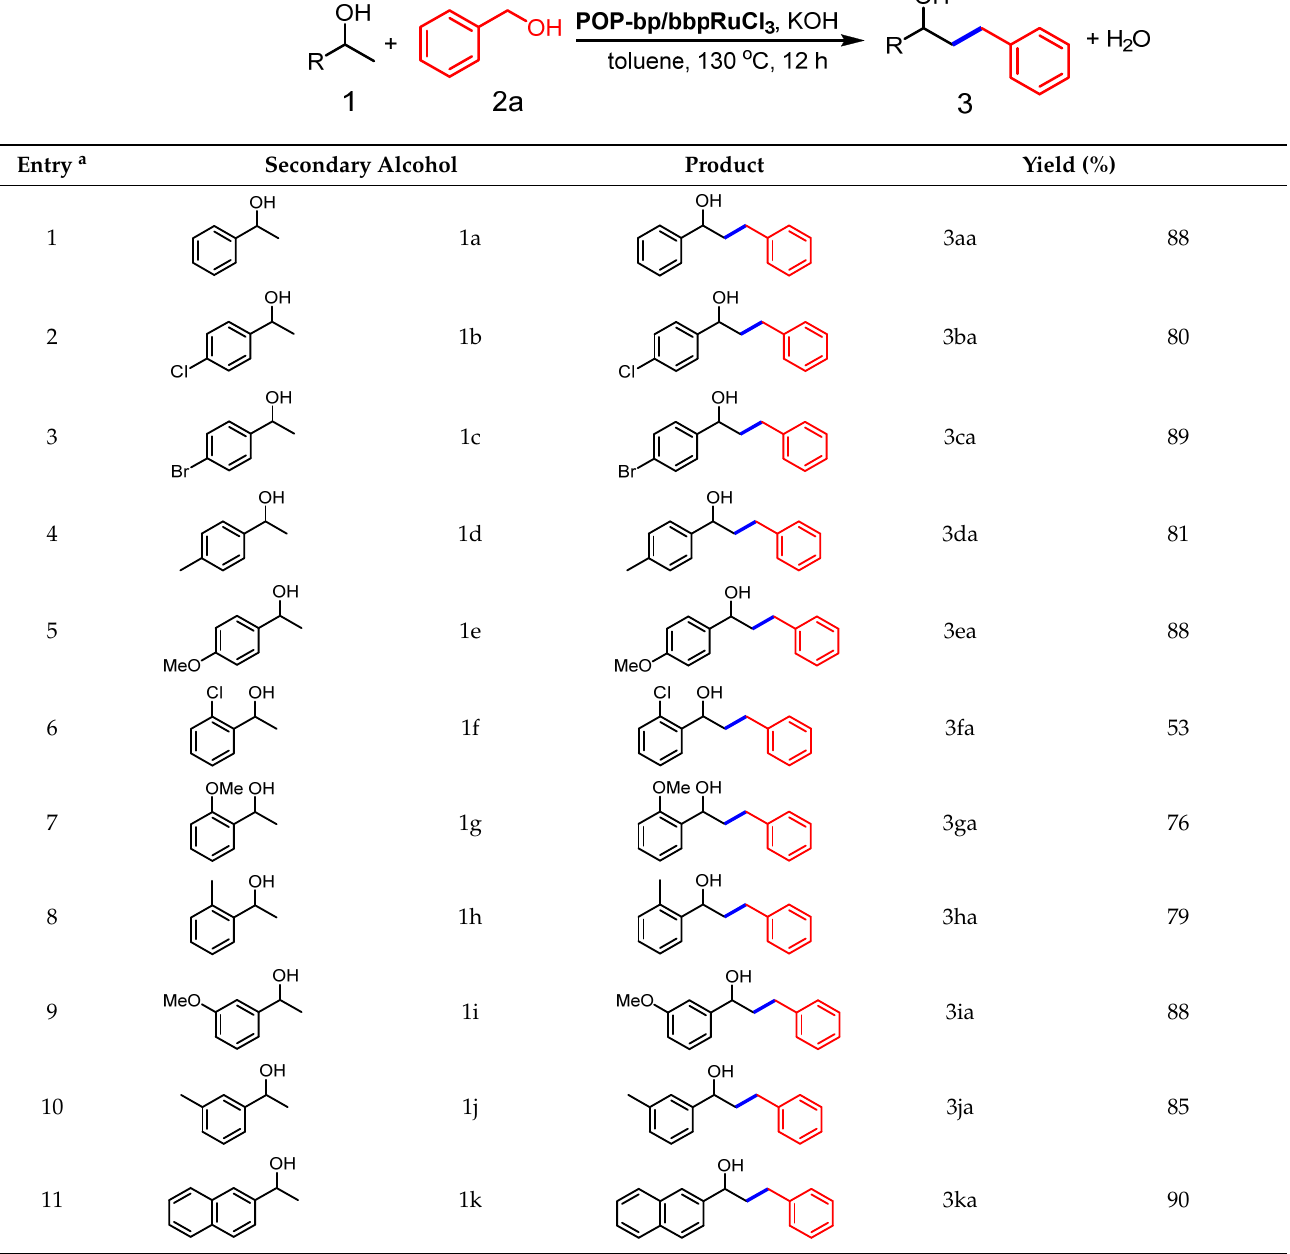
Table 3. β -Alkylation of various secondary alcohols with benzyl alcohol.